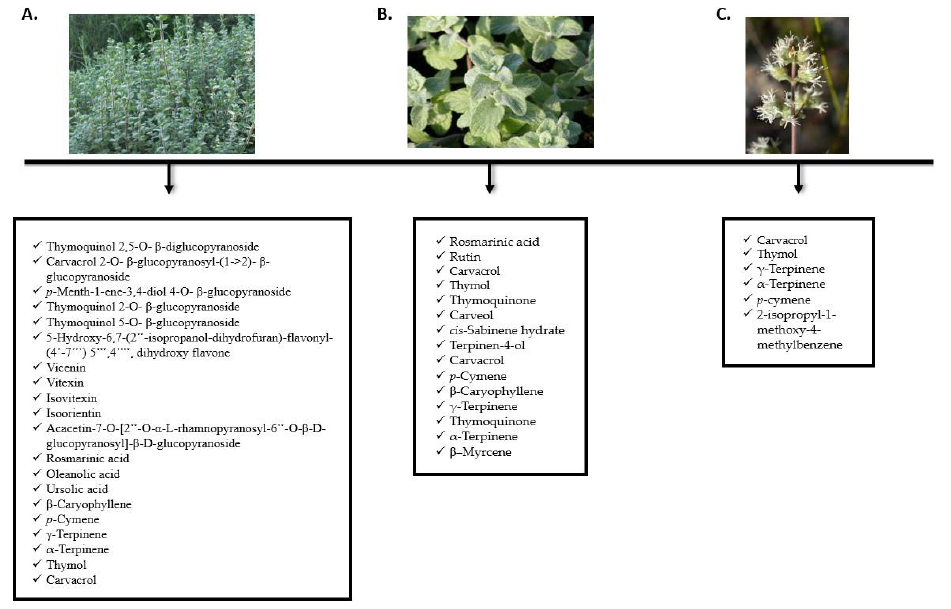
Figure 3. Major metabolites reported from various parts of Origanum syriacum . ( A ): Aerial parts, ( B ): Leaves, ( C ): Flowers.